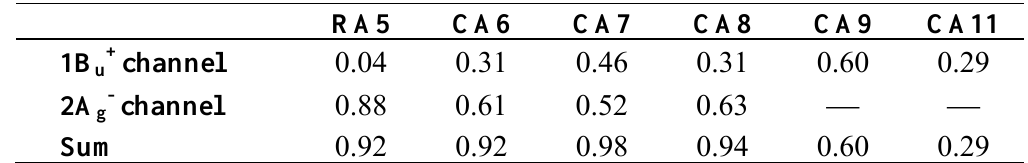
Table 1. Electron-injection efficiencies (in %) through the 1B u+ and the 2A g– channels and